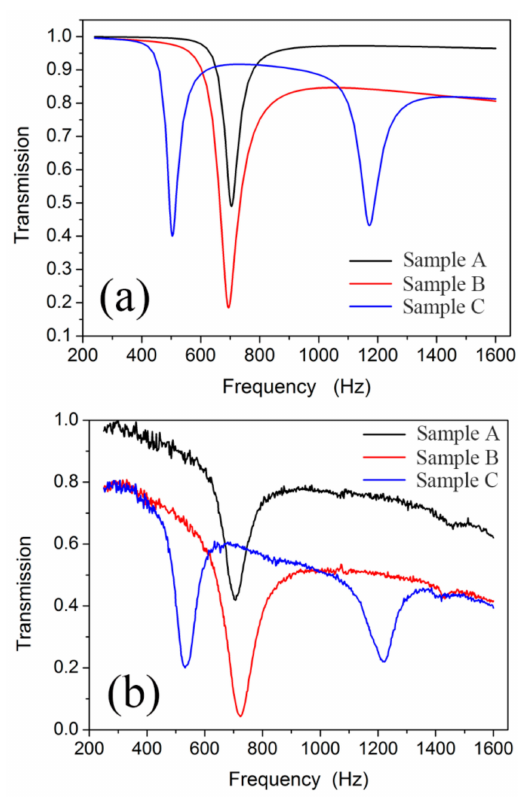
Figure 3. The simulated ( a ) and experimental ( b ) transmission curves of the first SHS-AMM (sample A), second SHS-AMM (sample B) and the NSHS-AMM (sample